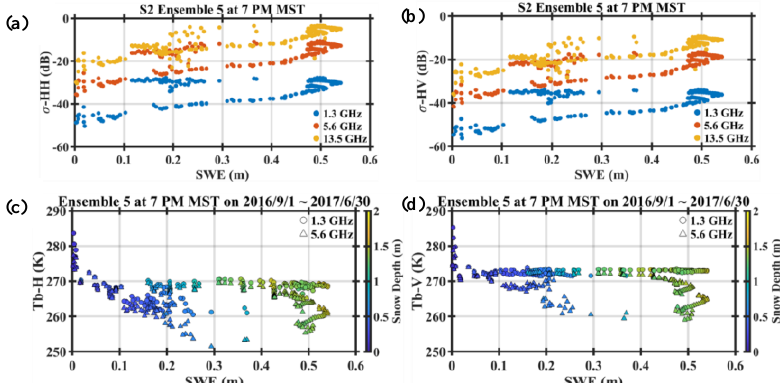
Figure 16. ( a, b ) Seasonal evolution of Ensemble 5 mean backscatter at 7 PM MST across the Grand Mesa throughout the snow season from 9/1/2016 through 6/30/2017. ( c, d ) Seasonal evolution of Ensemble 5 mean brightness temperatures at 7 PM MST across the Grand Mesa throughout the snow season from 9/1/2016 through 6/30/2017. The microwave behavior is similar for all polarizations. MST- Mountain Standard Time = UTC-7.